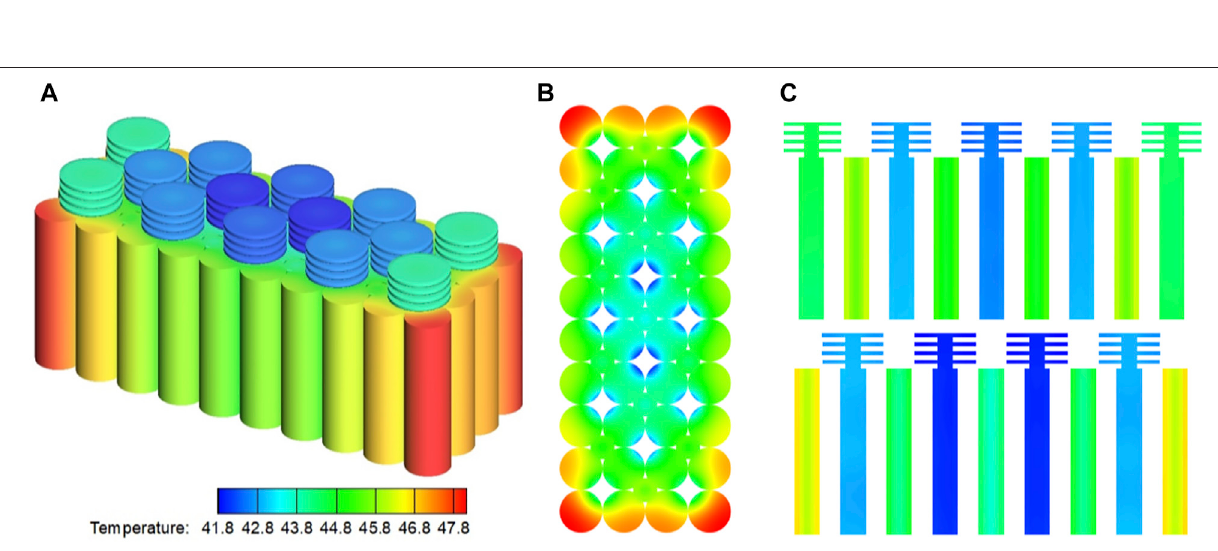
Frontiers in Energy Research |